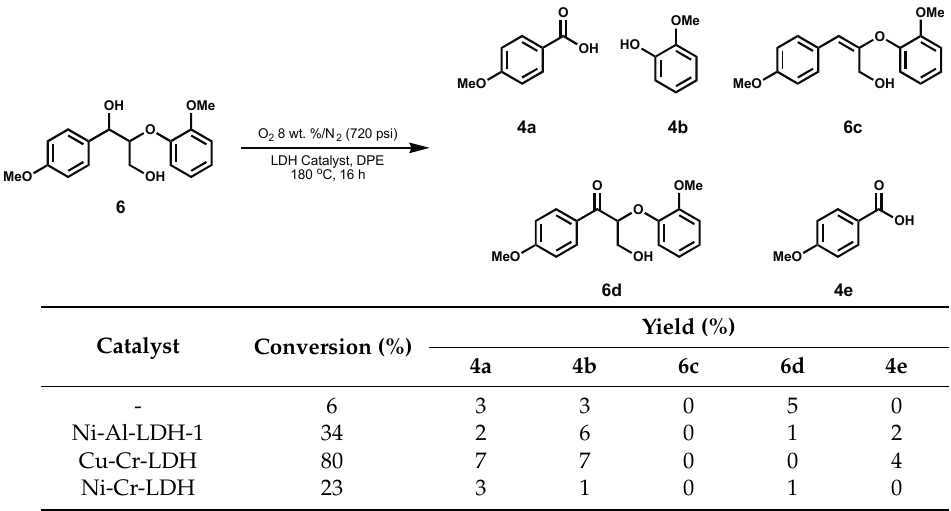
Table 11. Conversion of 6 over LDH catalysts in phenyl ether with O 2 .